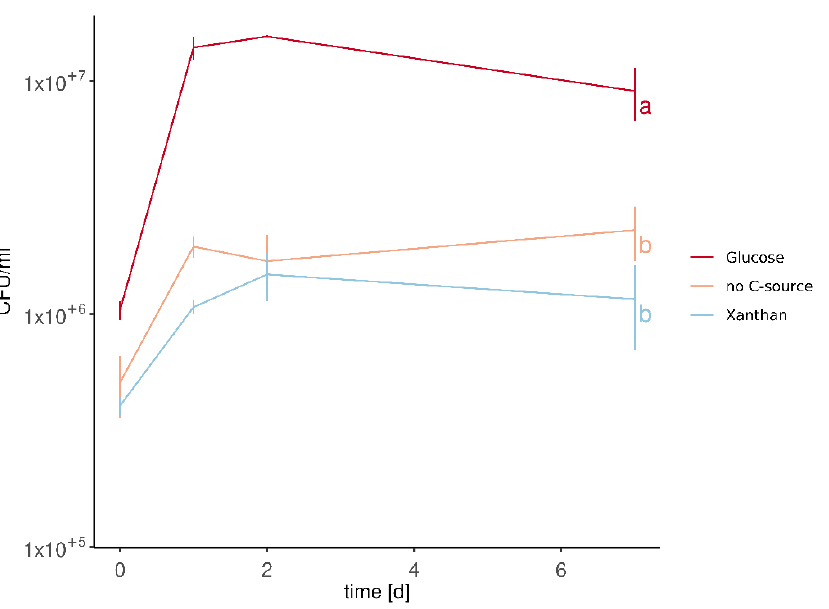
Figure 4. M. pulcherrima is not able to metabolise xanthan. M. pulcherrima was grown in YNB medium containing glucose (5 g/L) or xanthan (5 g/L) at 28 °C. The CFU was determined by counting cells using the SparkControl ® cell counting app (Tecan). Numbers are represented in a logarithmic scale. The averages and standard errors of three replicates are shown. Letters indicate statistical significance determined by a two-sided Kruskal – Wallis test with Dunn multiple comparisons test and Benjamini – Hochberg correction ( p < 0.05).